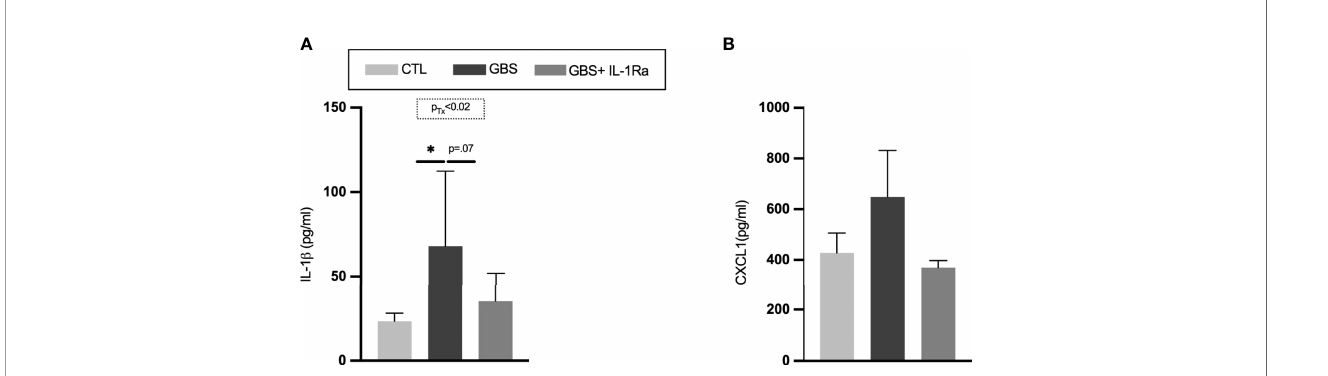
FIGURE 4 | Administration of IL-1Ra to the dam reduced the levels of IL-1 b in fetal sera. Mean titres of IL-1 b (A) , and CXCL1 (B) in circulating fetal sera. Data were collected from four individual experiments. Analyses were done by one-way ANOVA test between the experimental groups (CTL, GBS, and GBS plus IL-1Ra) when treatment was signi fi cant; * p < 0.05. Number (n) of male and female fetuses: CTL (n = 4-6), GBS (n = 5-7), and GBS plus IL-1Ra (n = 5-7). Bars show mean ± SEM. CTL, control; CXCL1, chemokine (C-X-C motif) ligand 1; GBS, group B Streptococcus ; IL-1, interleukin-1; IL-1Ra, IL-1 receptor antagonist; SEM, standard error of the mean; Tx, treatment.